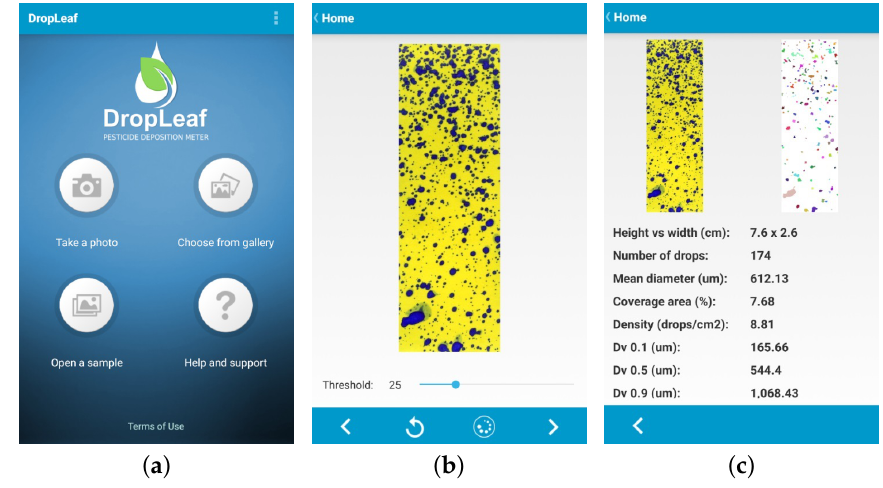
Figure 10. DropLeaf: ( a ) Main menu; ( b ) Captured image visualization; ( c ) Image processing